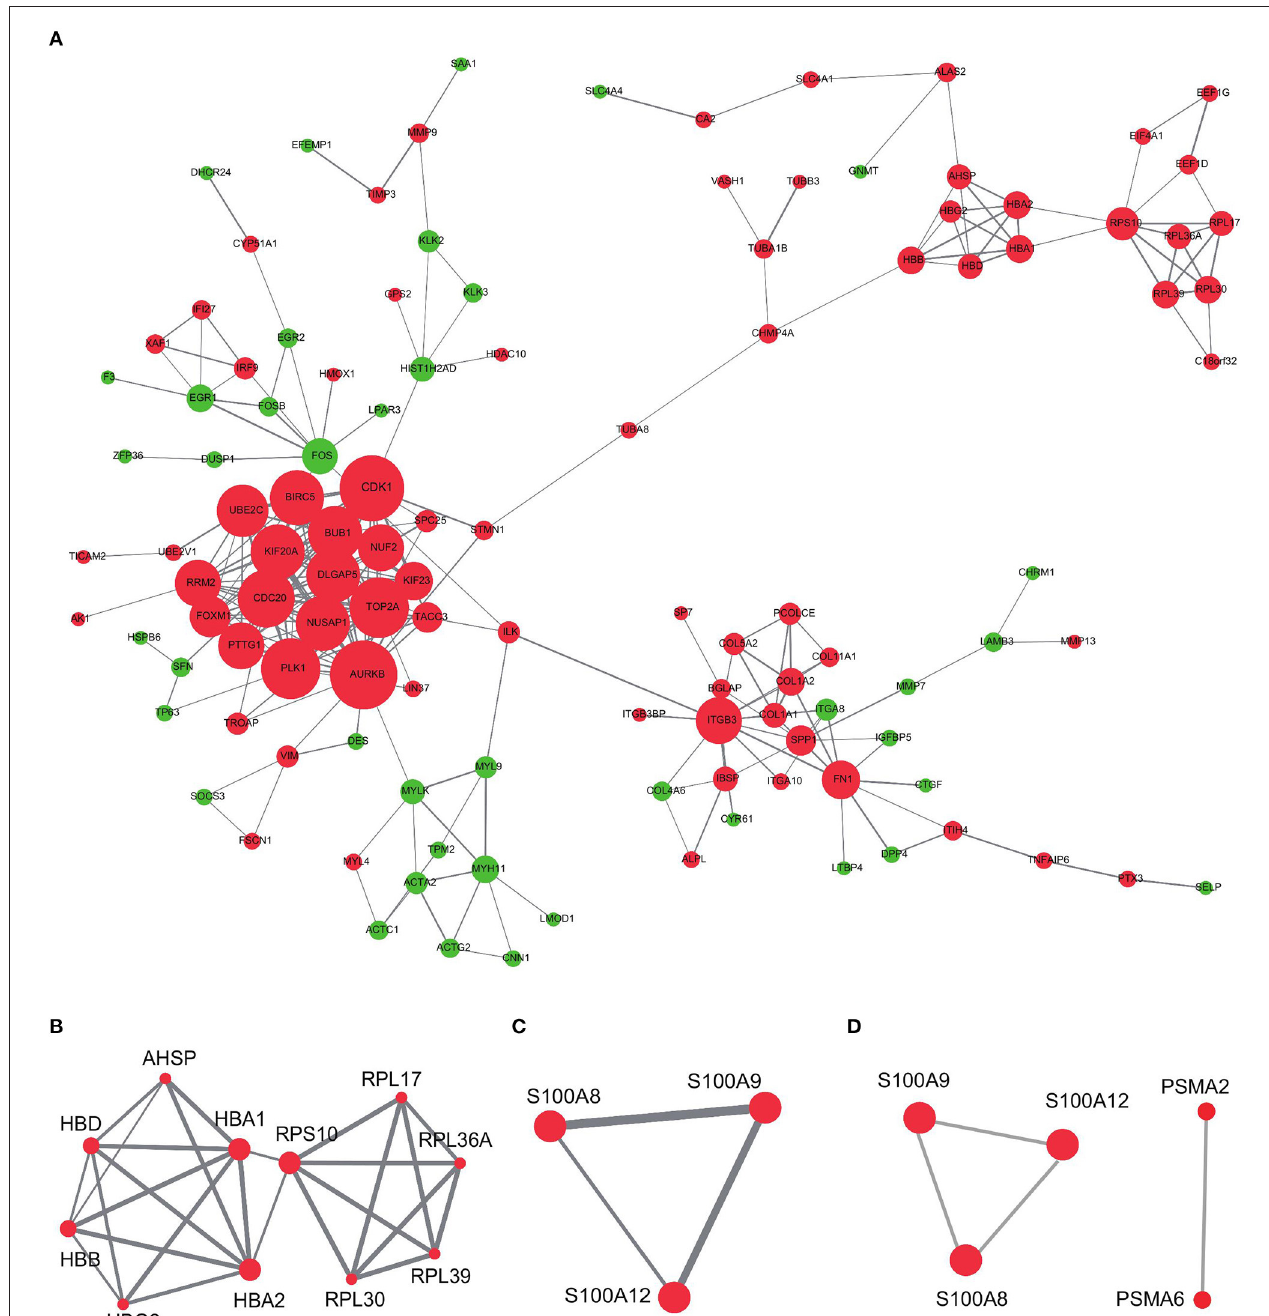
FIGURE 7 | PPI network analysis of differentially expressed genes in high- and low-risk groups. (A) PPI networks of differential genes in high-risk and low-risk groups. (B,C) MCODE mining of modules 2 and 14. (D) Top five hub genes identified using the CytoHubba plugin. Red represents upregulation and green represents downregulation of expression. The size of the dots represents the degree in the network; the line thickness represents the combined interaction score between genes obtained from the STRING database.